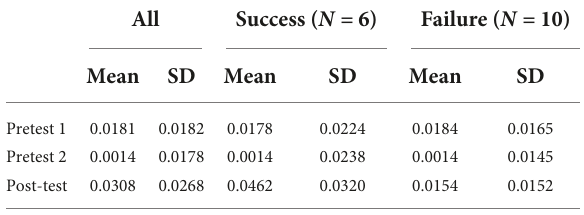
TABLE 5 Cerebral blood flow (prefrontal